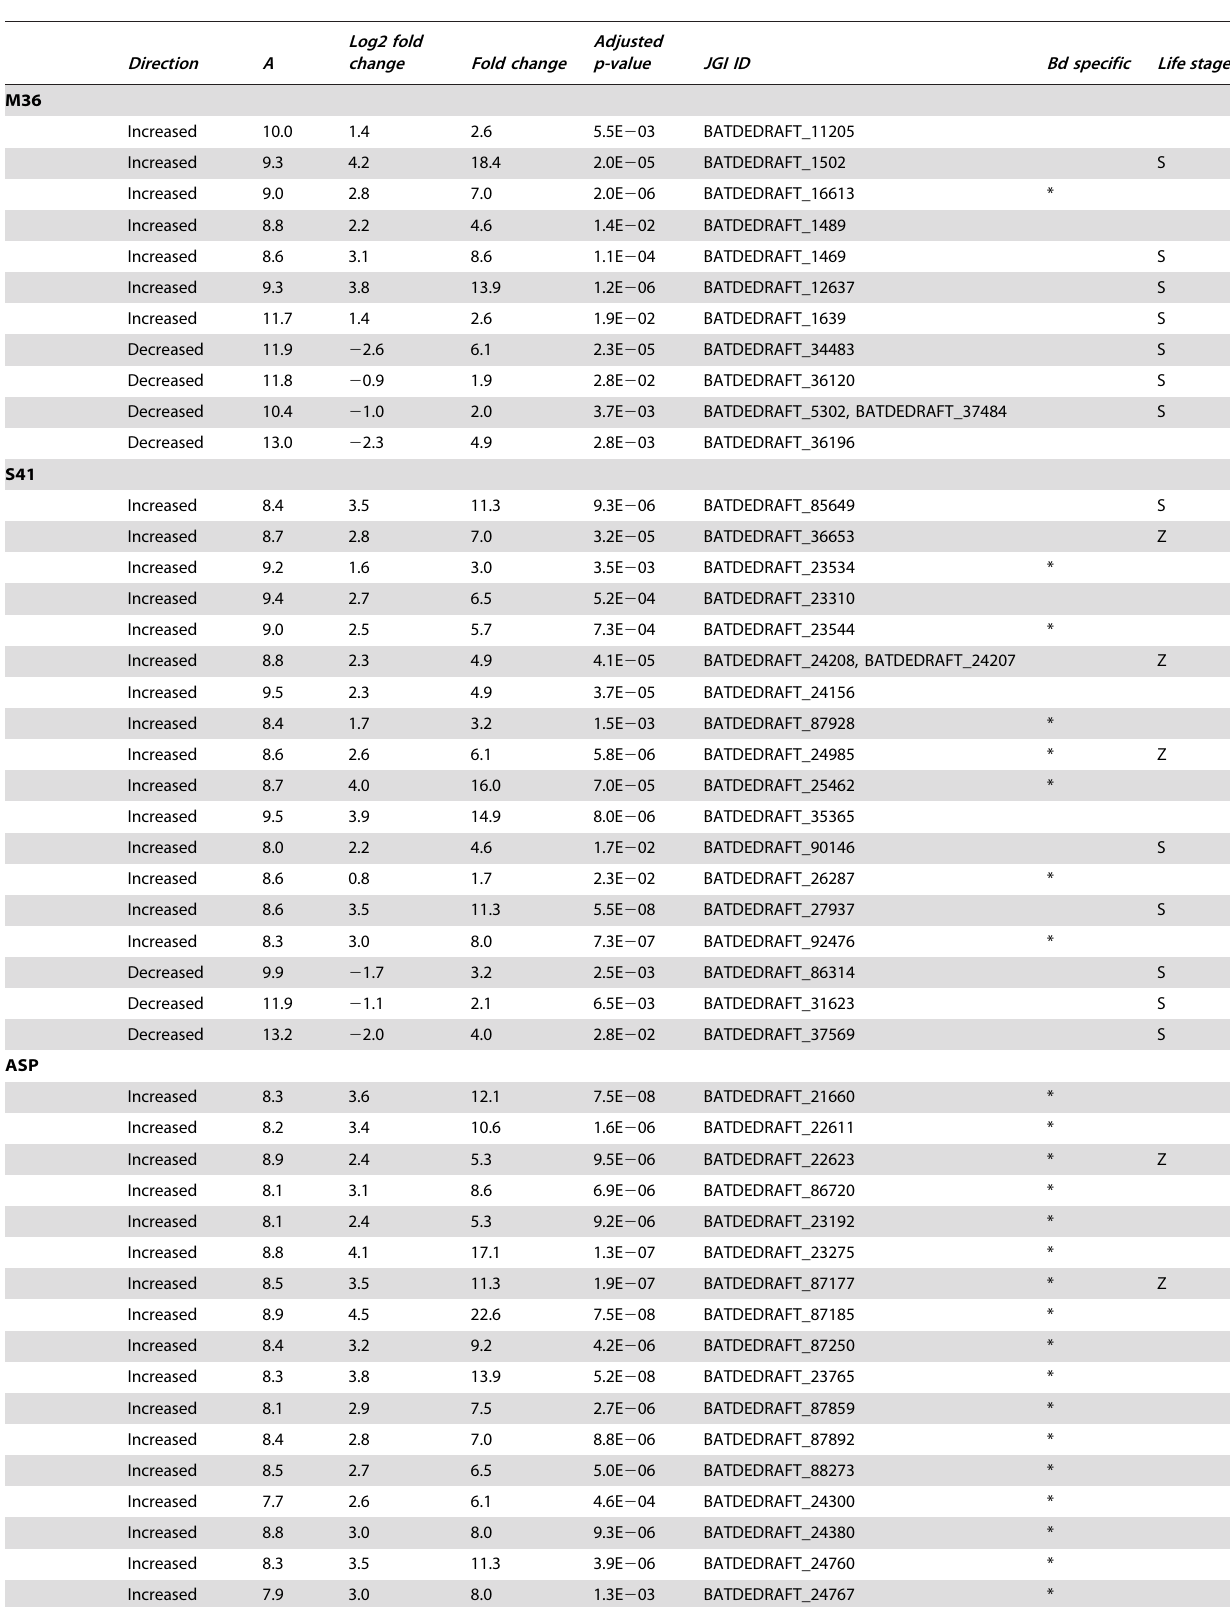
Table 2. Selected gene classes with differential expression in the two nutrient treatments.